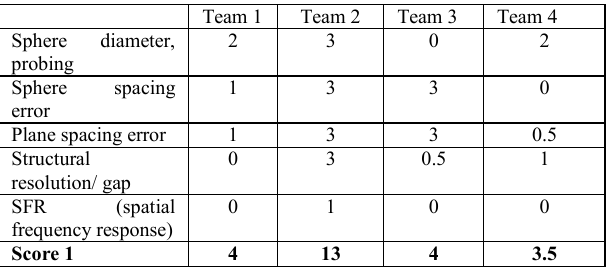
Table 5. Scores for technical capabilities for all teams.